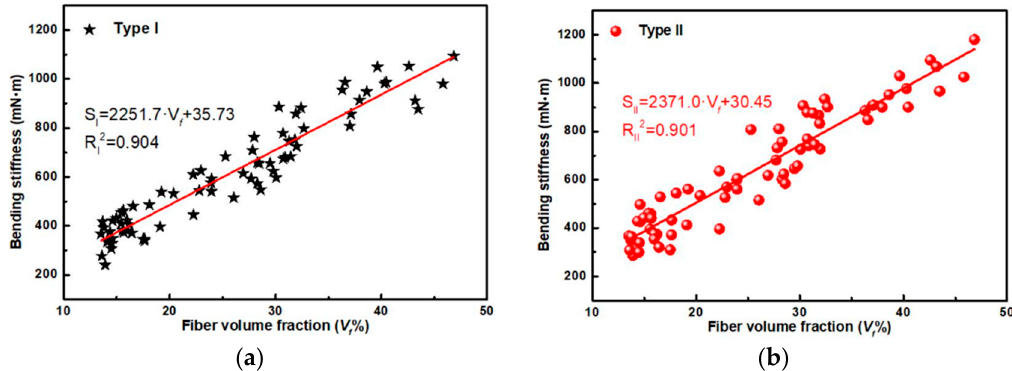
Figure 9. Relationship between bending stiffness and fiber volume fraction under Type I ( a ) and II ( b ). Table 2. Predicting value of mechanical properties of fibers and parenchyma cells by a rule of mixture.